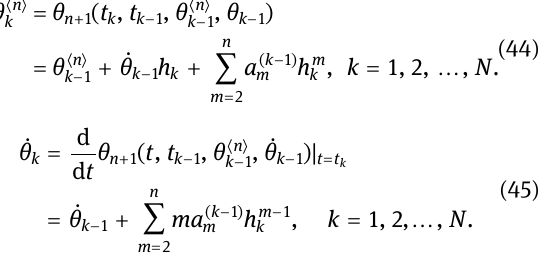
30 ⟨ ⟩ with step - size h 0.3 = ( dots ) . ( c ) Absolute error when we compare k